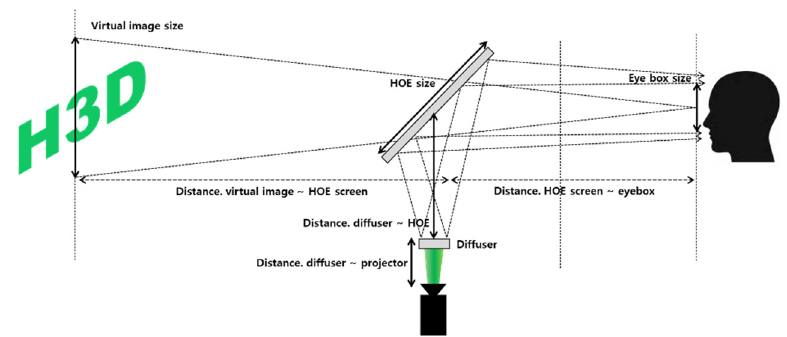
Figure 5. Floating hologram system using a HOE.